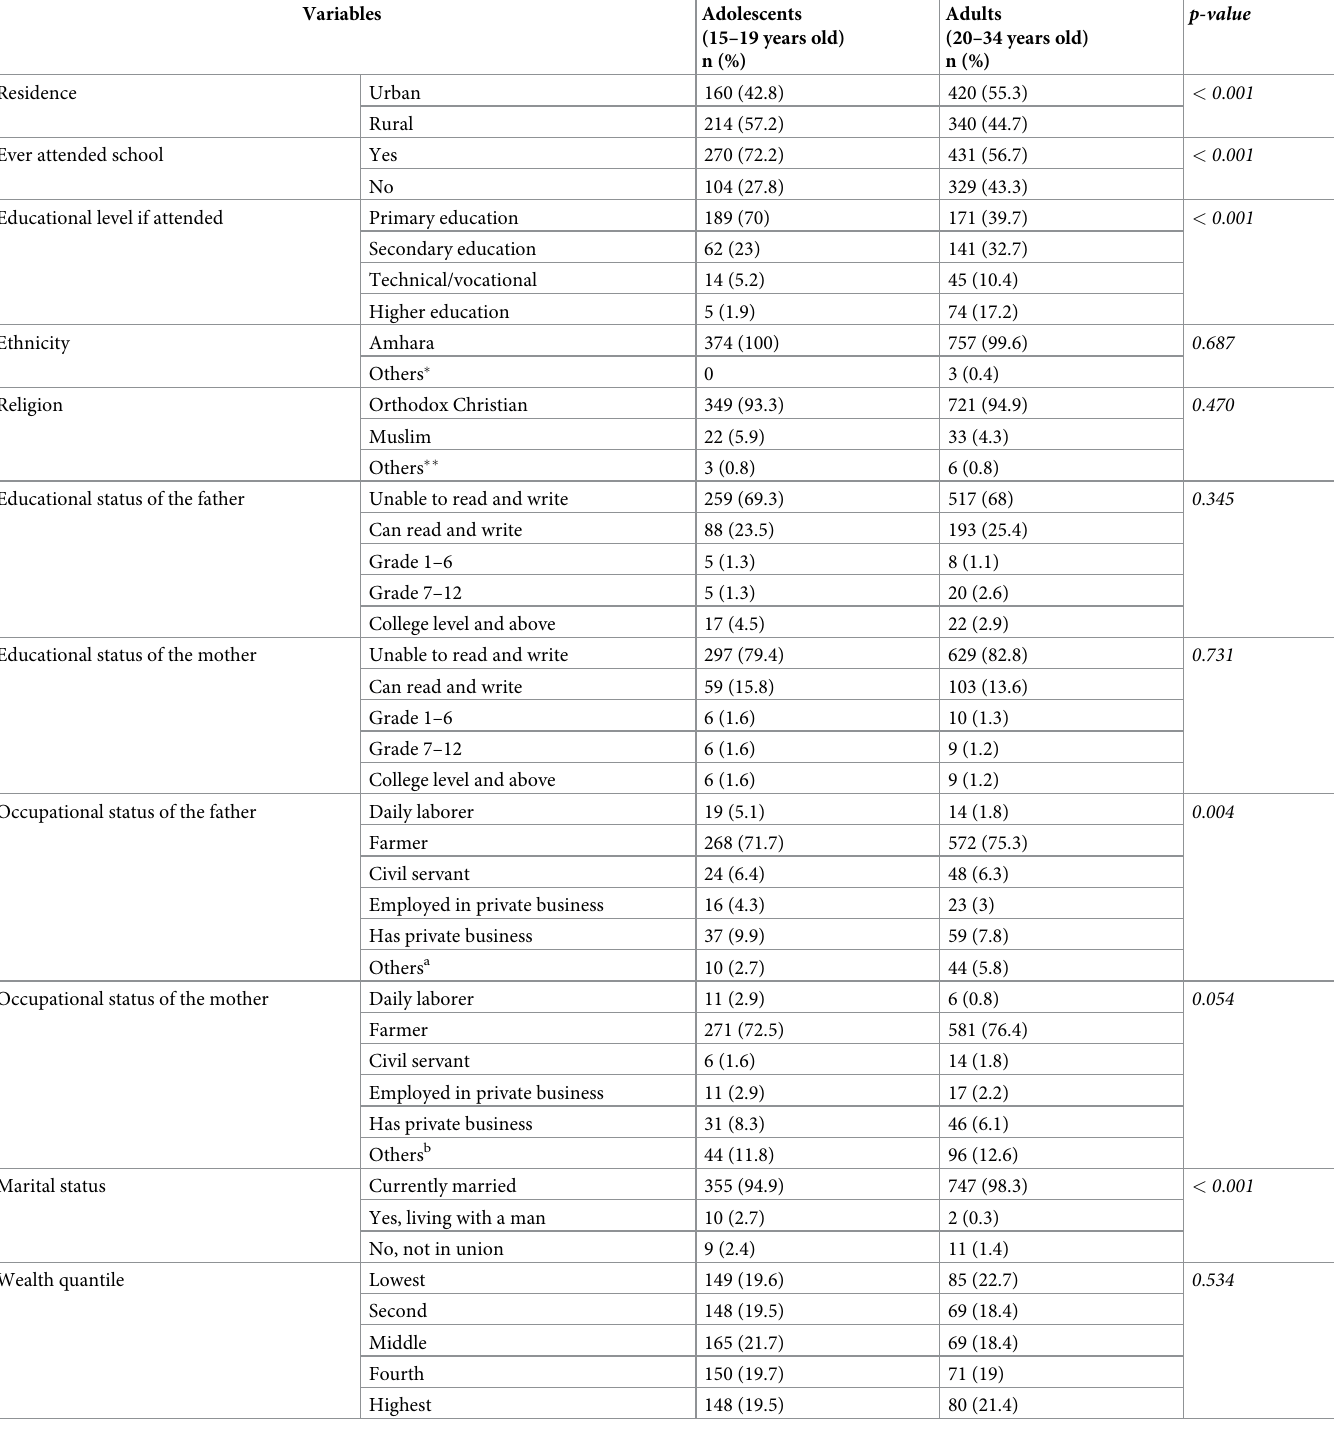
Table 1. Sociodemographic characteristics of women who gave birth at public health facilities in East Gojjam zone, Northwest Ethiopia,